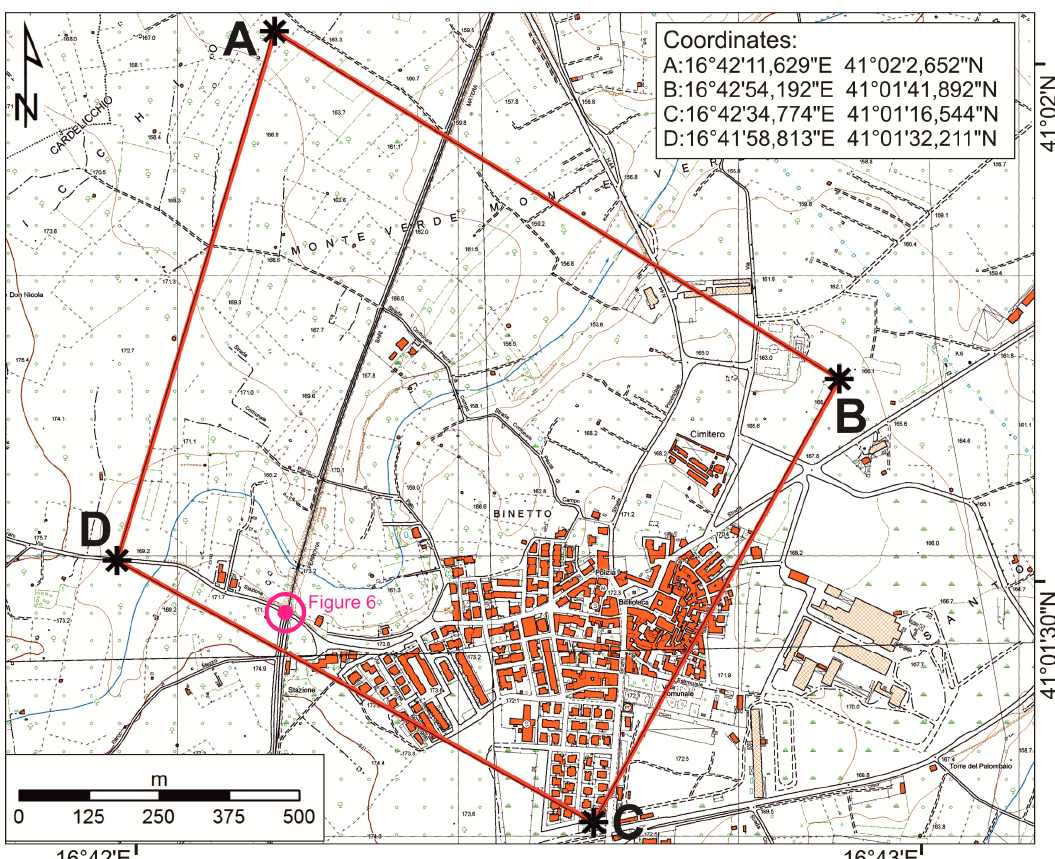
Figure 4. Study area extended for a total area of about 1 km 2 , and represented through a polygon of four vertices (reference system UTM WGS84 33N zone).